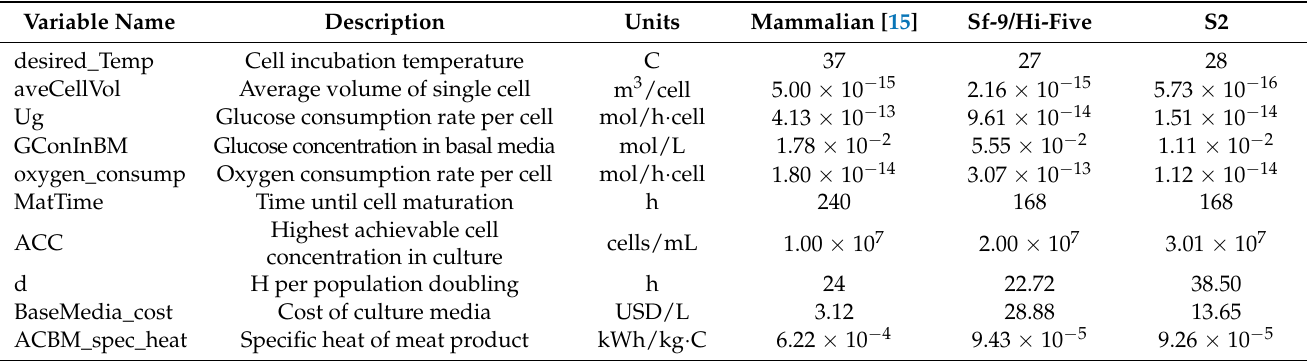
Table 1. Variables changed within code based on cell type with variable description, units, mam- malian values from Scenario 1, and baseline insect values. See Appendices A and B for insect value calculations and references